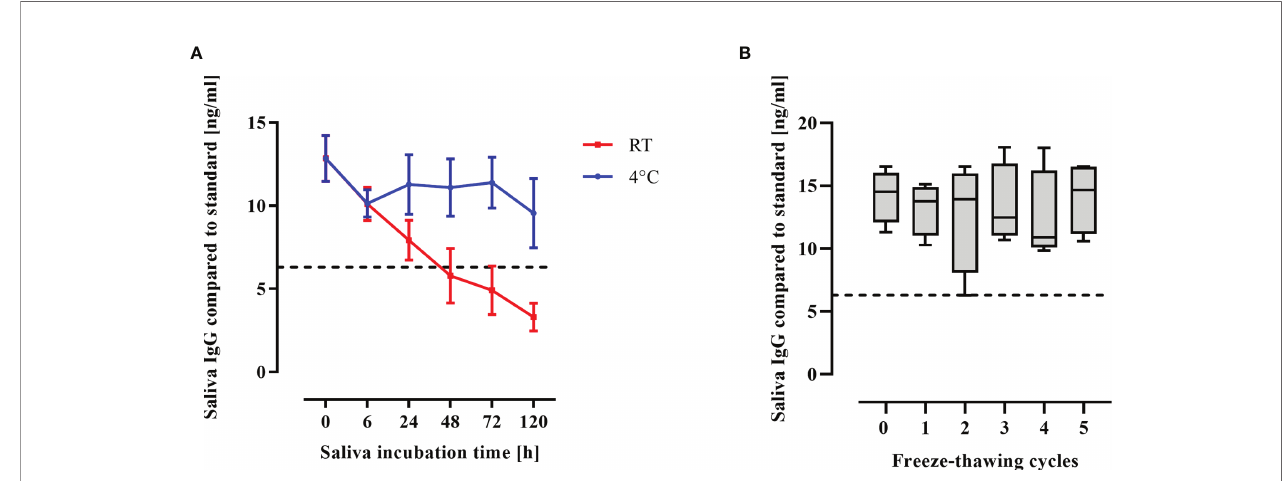
FIGURE 4 | Antibody stability in saliva. (A) Saliva was kept at RT or at 4°C for respective durations (h) after collection and SARS-CoV-2 IgG concentrations were measured by saliva ELISA. Mean and standard error of the mean of 4 biological replicates is shown. (B) Collected saliva was subjected to freeze-thaw cycles and IgG concentrations were measured by saliva ELISA. IgG concentrations is shown as boxplots. Dashed line: Cutoff for antibody